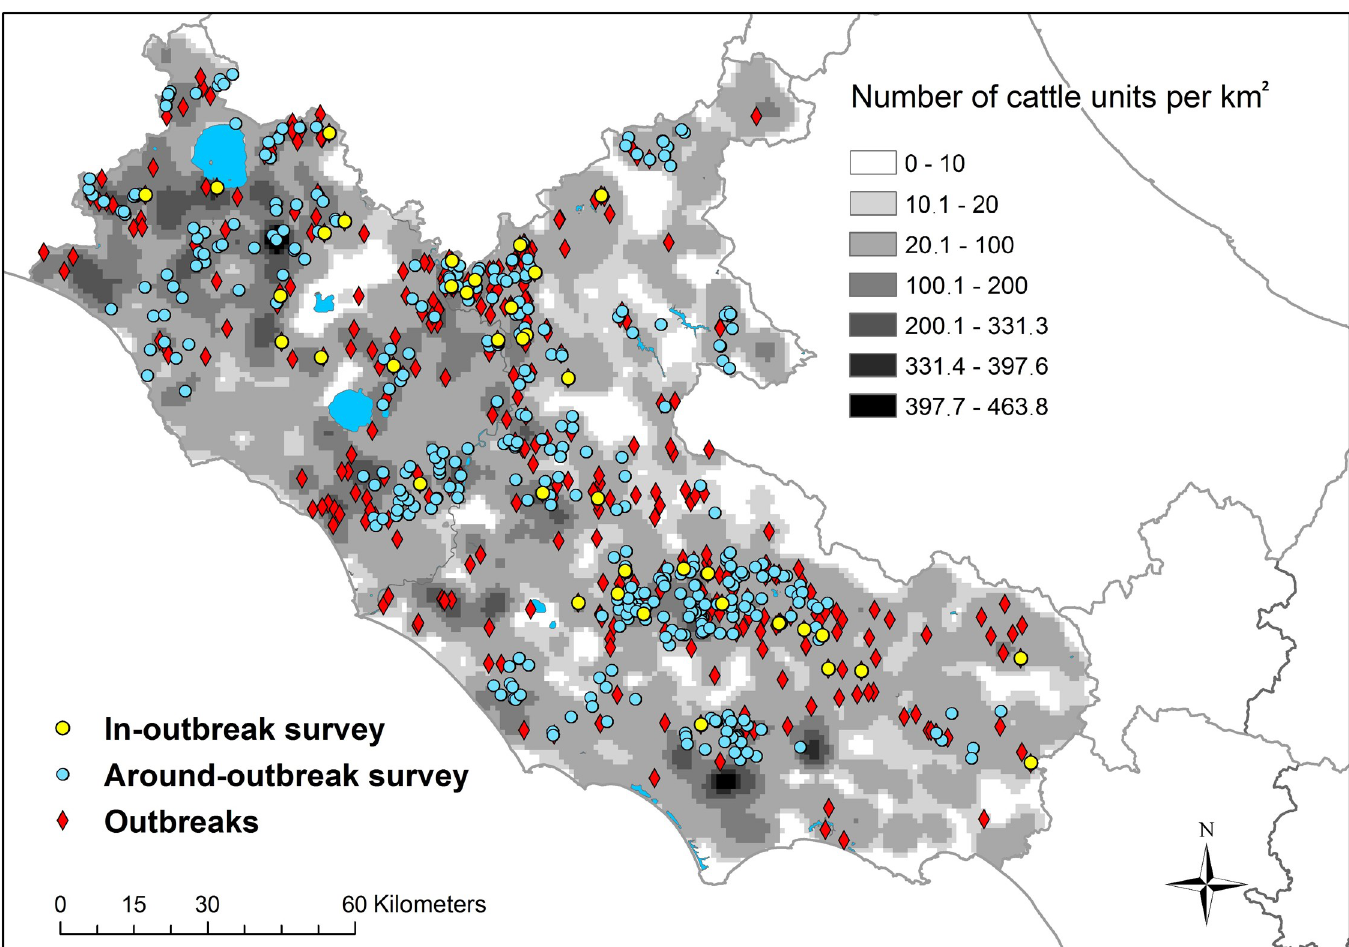
Fig 1. Location of bluetongue outbreaks, IO herds, AO herds and number of cattle units per km 2 in the Lazio region in